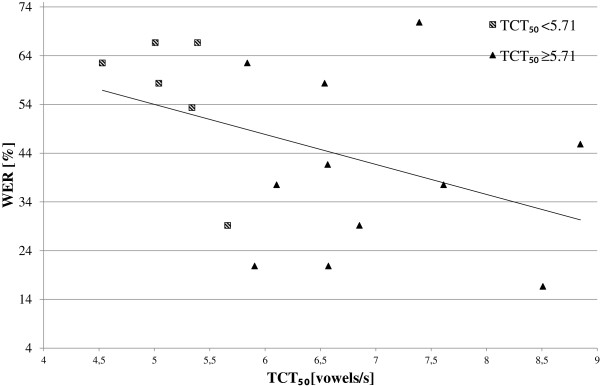
Relationship between TCT50and WER for hearing impaired children.